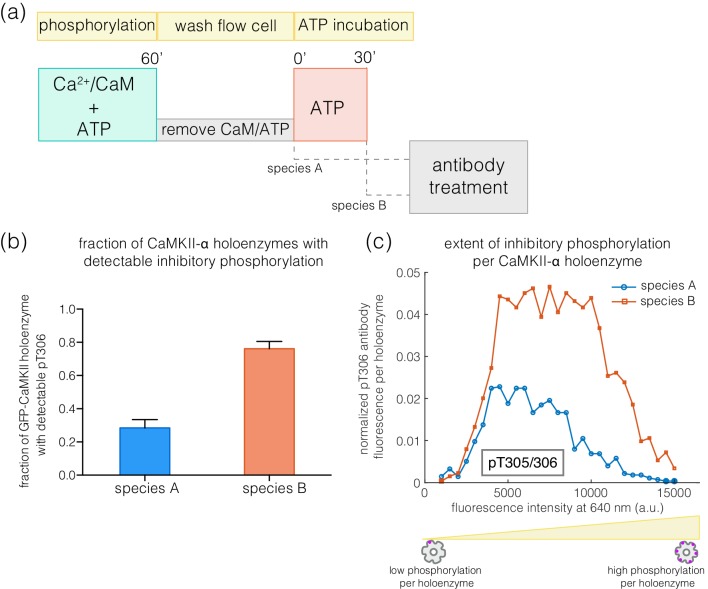
Inhibitory autophosphorylation status of activated CaMKII-α.(a) Schematic diagram showing the experimental set up. CaMKII was activated, followed by a wash to remove the components of the activation buffer. The pre-activated CaMKII (species A) is then treated with Mg2+-ATP for 30 min to generate species B. (b) Fraction of CaMKII-α holoenzymes with detectable phosphorylation at Thr 305/306 is plotted for each species. (c) Intensity distribution of pThr 305/306 (640 nm) for species A and species B with detectable phosphorylation . The area under each intensity histogram is scaled by the fraction of holoenzymes that show no detectable phosphorylation under that condition (see Materials and methods for details of normalization).